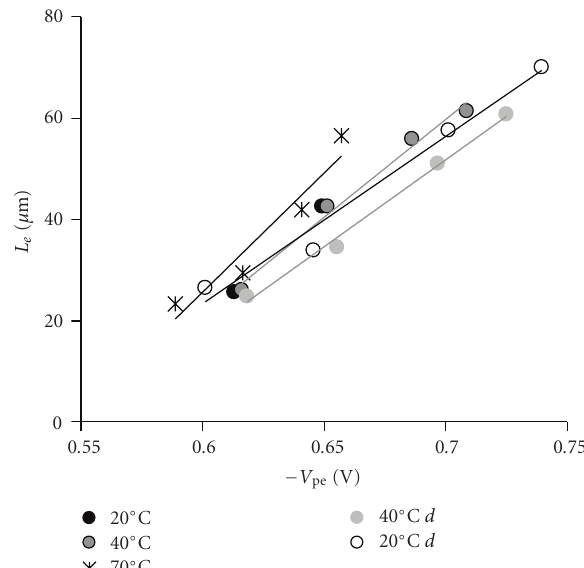
Figure 13: Electron di ff usion lengths in the TiO 2 film, as a function of photoelectrode voltage, at di ff erent temperatures; second set of EIS measurements. Letter “ d ” after the temperature value indicates the downward sweep of the temperature